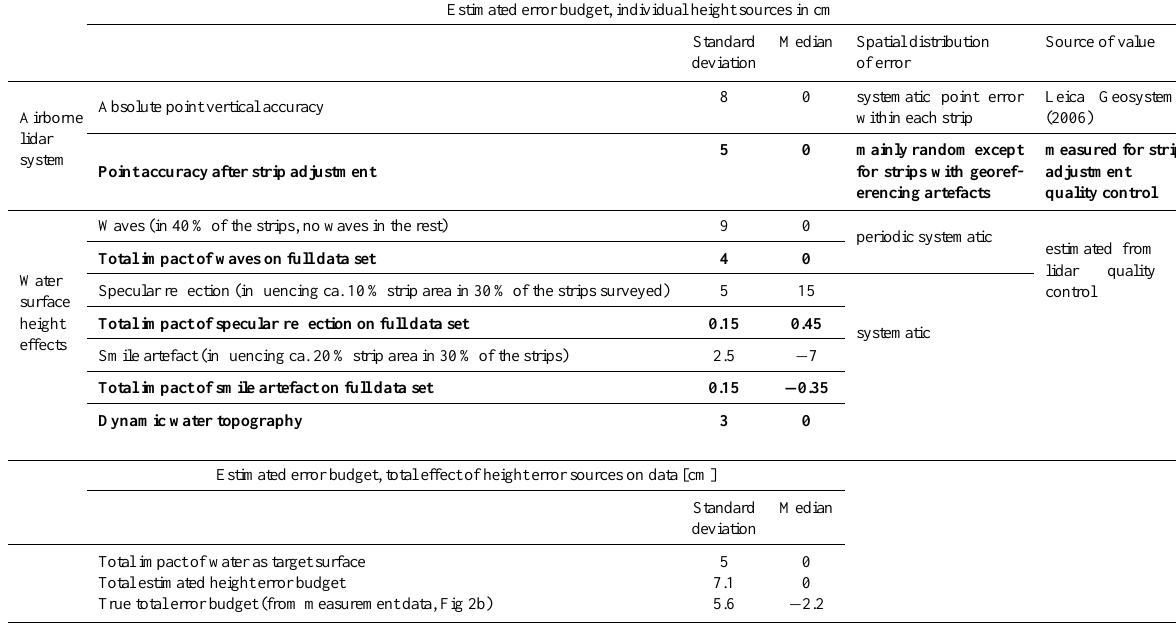
Table 1. Error budget, including standard deviation and median of each individual error source and the theoretical error propagation, com- pared with the dispersion found in the measurement data. Lines indicated in bold influence the final error budget. Lines not in bold show intermediate calculation steps, they only apply to the theoretical case without strip adjustment (Absolute point vertical accuracy) or to the individual strips affected by water artefacts. The total impact of water artefacts was calculated by averaging these values across the total data